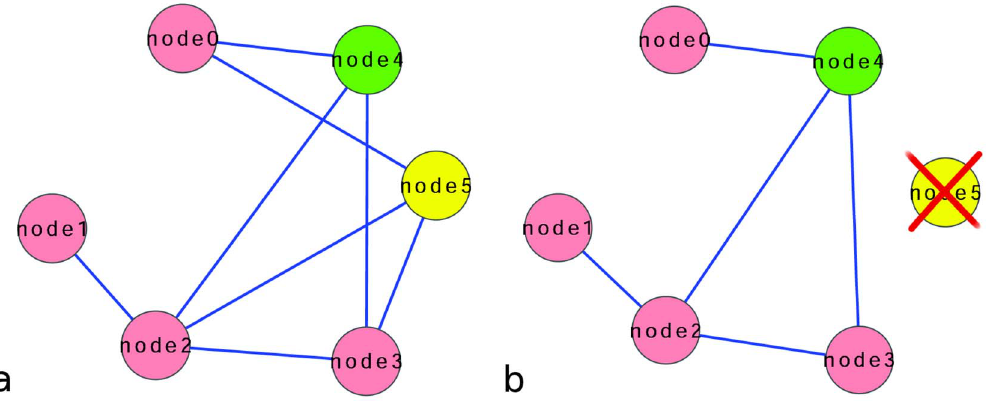
Figure 1. Betweenness interference. a . Node5 and node4 are in the shortest paths from node0 to the other nodes. b . Node5 have been removed. Node4 is now essential for connecting node0 to the rest of the network: it is the only node in the shortest paths connecting node0 to the other nodes: node4 betweenness increases.